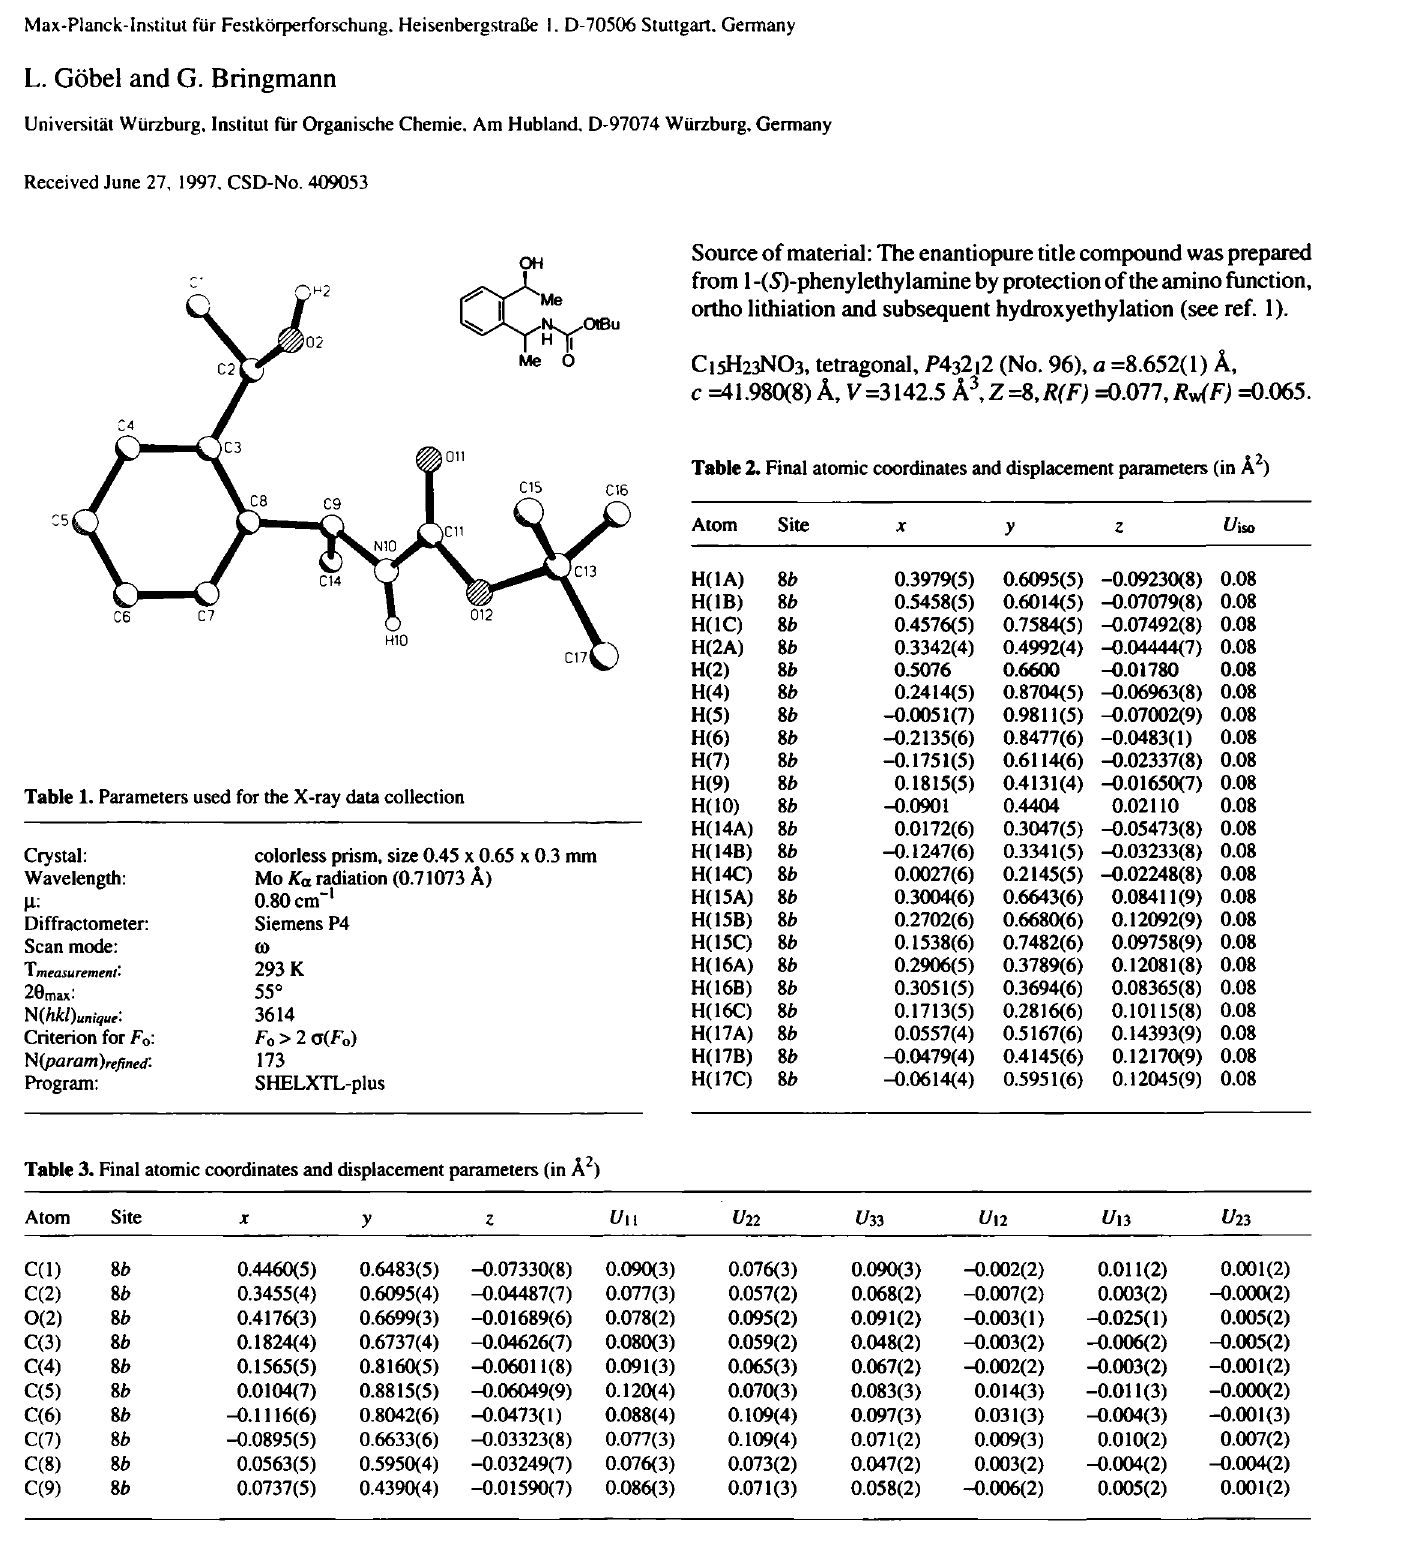
Source of material: The enantiopure title compound was prepared from 1 -(5)-phenylethylamine by protection of the amino function, ortho lithiation and subsequent hydroxyethylation (see ref. 1).